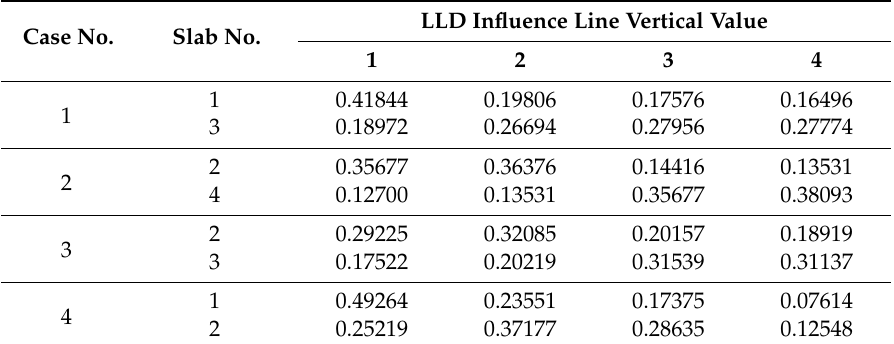
Table 5. LLD influence lines for damage cases listed in Table